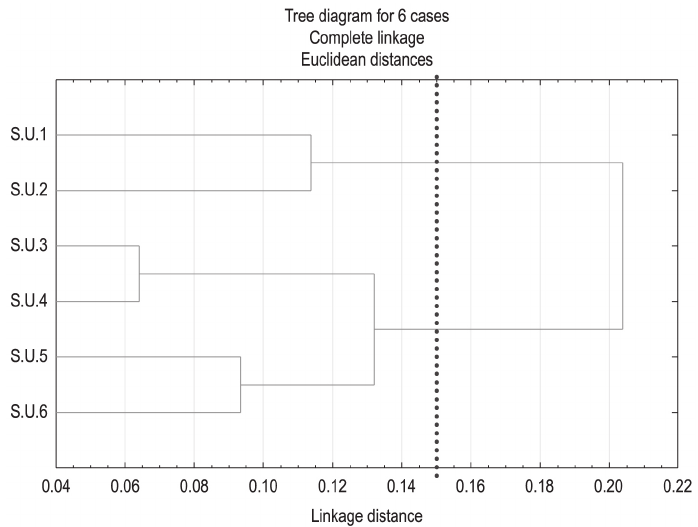
Figure 2. Dendrogram of cluster analysis based on six abiotic variables (pH-value, water temperature, electrical conductivity, turbidity, salinity and dissolved oxygen), macroinvertebrates abundance and richness in six sampling units